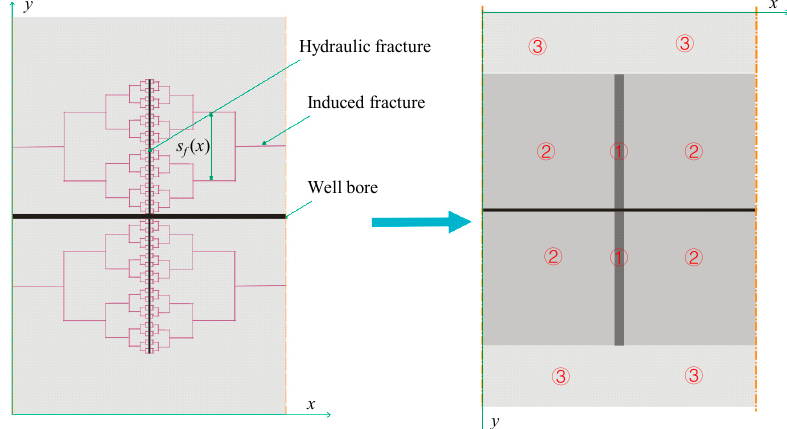
Figure 1. The physical model of multi-phase flow in multi-porosity media of a multi-fractured horizontal well.